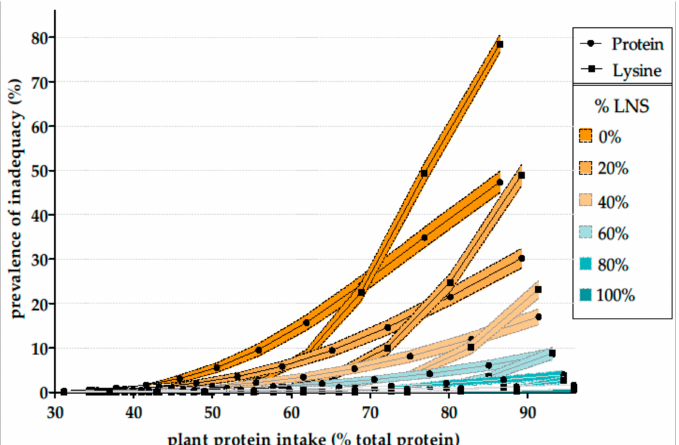
Figure 3. Prevalence of protein and lysine adequacy (% of the INCA2 study population, n = 1678) in simulations of a reduction in animal protein intake by gradually balancing it against the same amount of energy from a replacement combination composed of plant foods already consumed by individuals and a mixture of legumes, nuts and seeds. For example, the “40%” curves show the protein and lysine inadequacy when substituting animal protein with a combination of 40% of protein from legumes, nuts and seeds, and 60% of plant protein from foods already consumed by the individuals. The filled area represents the 95% confidence interval. LNS: legumes, nuts and seeds. Reproduced with permission from the authors